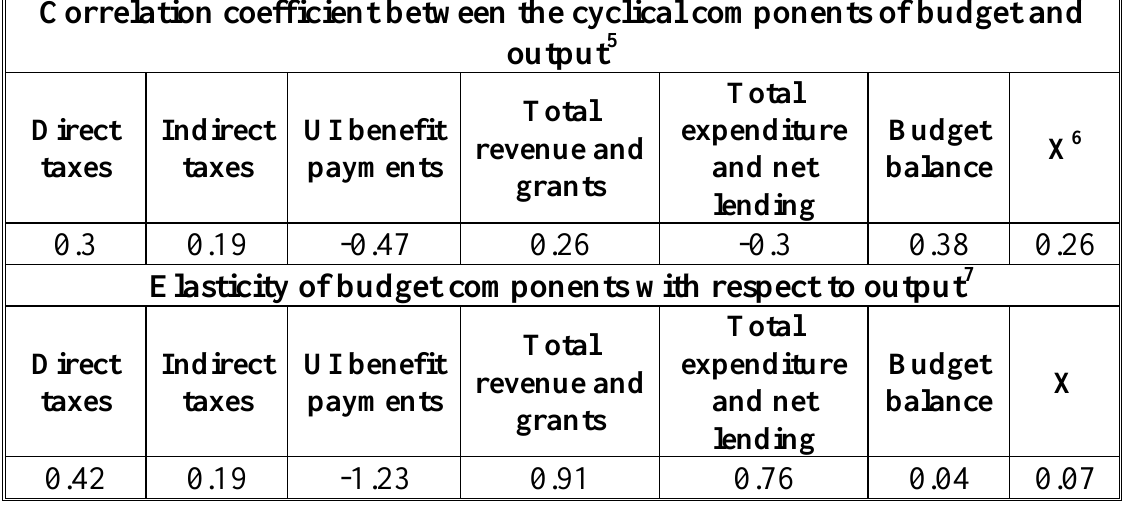
Correlation coefficients and elasticities of budget